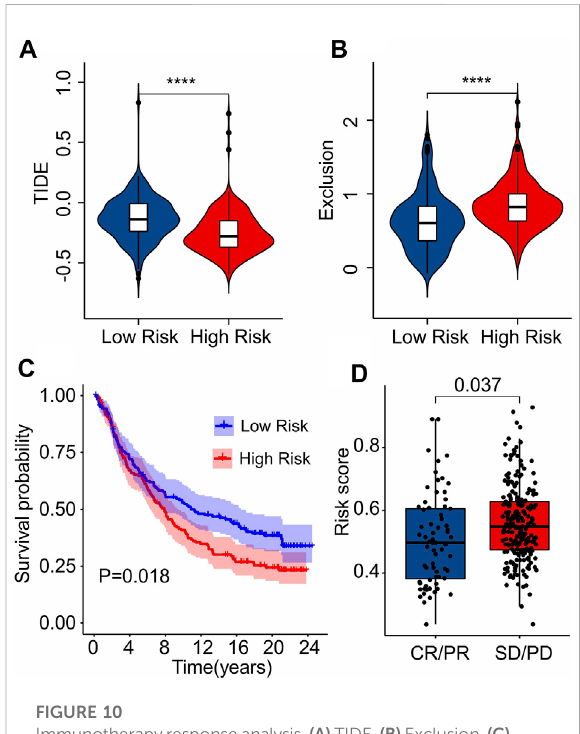
FIGURE 10 Immunotherapyresponseanalysis. (A) TIDE. (B) Exclusion. (C) The Kaplan-Meier curves shows the OS rate of patients in the low- and high-risk group in anti-PD-L1 cohort (IMvigor210 cohort). (D) The risk score in CR/PR and SD/PD indicates a signi fi cant difference in the IMvigor210 cohort. PR, Partial Response, PD, Progressive Disease; SD, Stable Disease, and CR, Complete